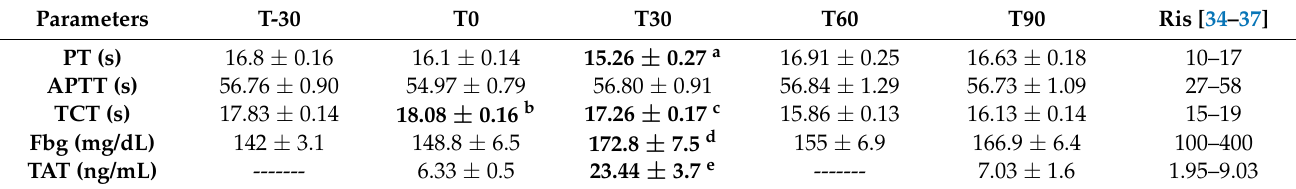
Table 3. Means ± SD of clotting parameters. Parameters significantly modified are in